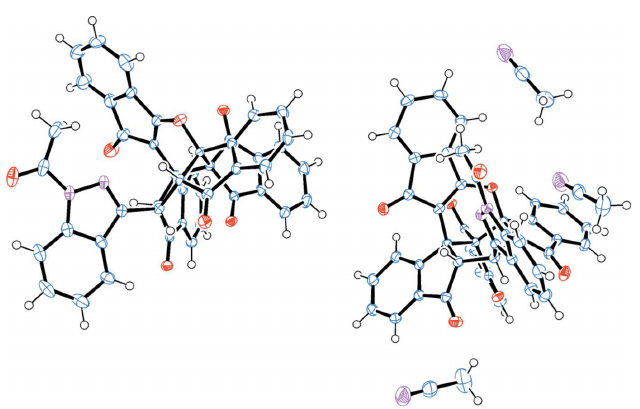
Figure 1 ORTEP representation of the asymmetric unit of the crystal, containing